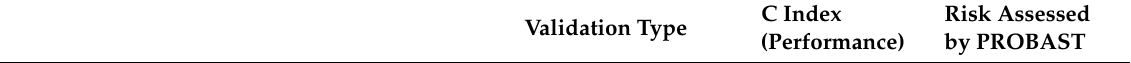
Table 4. An overview of COVID-19 infection diagnosis and prognosis prediction